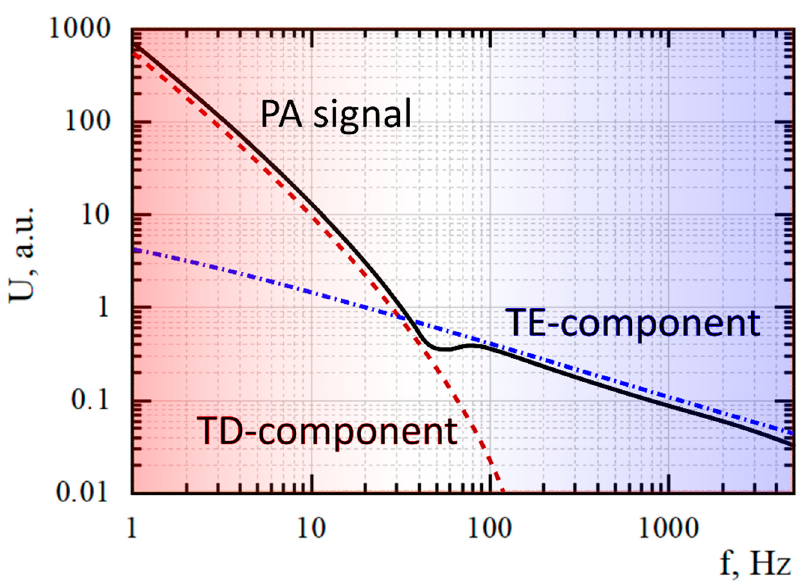
Figure 5. Simulated amplitude–frequency dependencies of the PA signal for the sample based on the open-cell PA configuration. Dashed and dash-dotted lines show the calculated dependencies for the TD component and the TE component of the PA signal, respectively, and the solid line shows the result of summation.